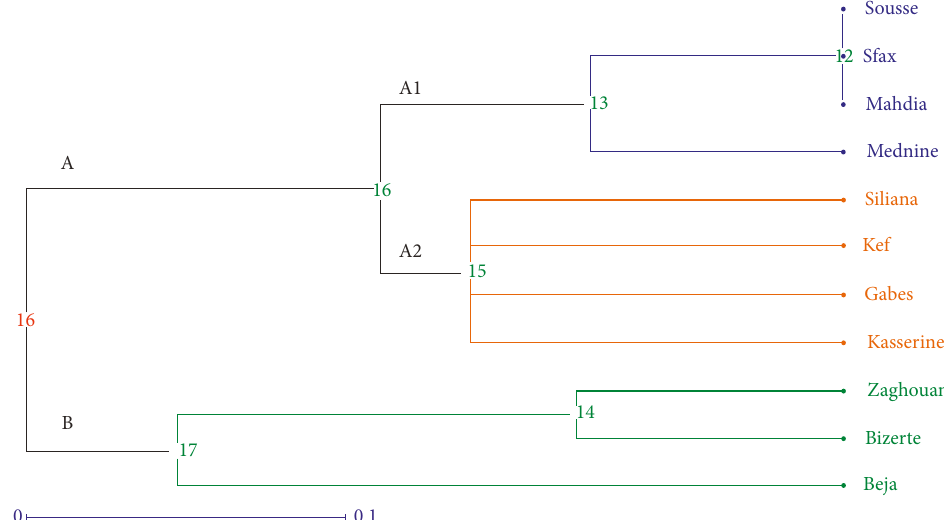
Figure 2: UPGMA dendrogram representing the genetic relationships between the 11 studied populations of barley landraces based on six cpSSR (chloroplast microsatellites) molecular markers. Table 5: Analysis of molecular variance (AMOVA) between the 11 populations of Tunisian barley landraces applying six cpSSR (chloroplast microsatellites) molecular markers.